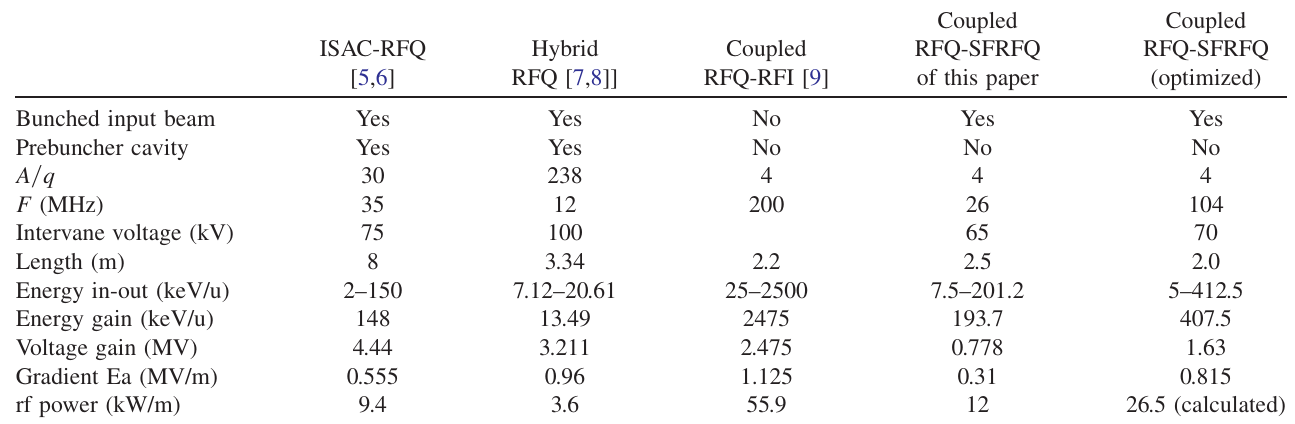
TABLE VII. Characteristics of different rf